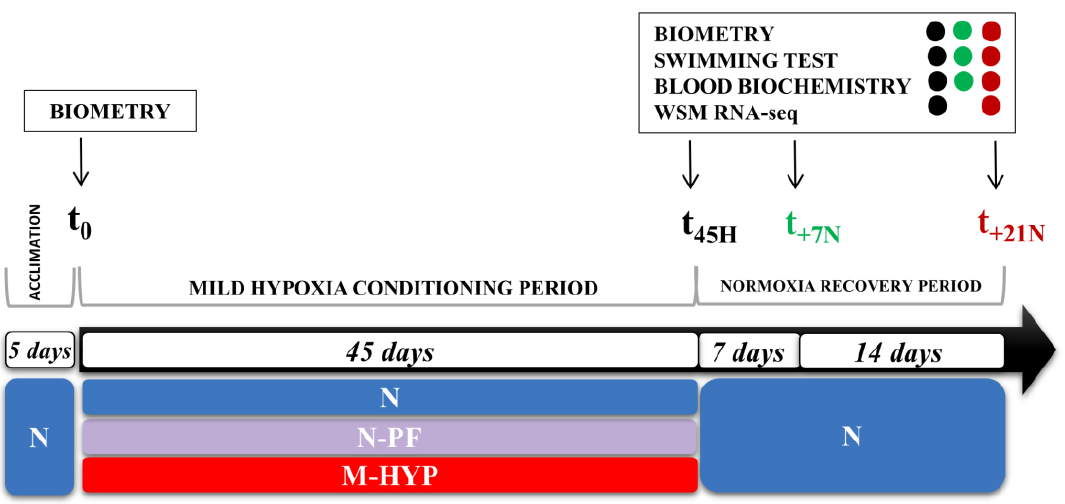
Figure 1. Experimental setup showing the timing and type of data recorded at each sampling point. After 45 days of mild-hypoxia conditioning (t 45H ), 12 overnight-fasted fish per experi- mental condition were randomly selected and anesthetized (between 10:00 and 12:00 a.m.) with 100 mg/L 3-aminobenzoic acid ethyl ester (MS-222, Sigma, Saint Louis, MO, USA). Blood was taken from caudal vessels with heparinized syringes in less than 3 min for all the fish from the same tank. The haematocrit (Ht) and haemoglobin concentration (Hb) were determined in fresh samples. The remaining blood was centrifuged at 3000 × g for 20 min at 4 ◦ C, and plasma samples were frozen and stored at − 20 ◦ C until biochemical and hormonal analyses were performed. Prior to skeletal muscle collection, fish were killed by cervical section and representative portions of the dorsal tissue were excised and immediately snap-frozen in liquid nitrogen and stored at − 80 ◦ C until extraction of total RNA and tissue lactate quantification. At this stage, 6–7 additional fish per experimental condition were used for swim tests (see Section 2.3), and blood and skeletal muscle were rapidly taken from exhausted fish for biochemical and transcriptomic analyses. The re- maining fish were kept under normoxia and continued to be fed until visual satiation for three additional weeks, which constituted the normoxia restoration period with additional sampling points at Week 1 (t +7N ; 6 fish) and Week 3 (t +21N ; 7 fish) for swim tests as well as biochemical and transcriptomic analyses. Data on body weight were retrieved for all fish at t 0 , t 45H , t +7N , and t +21N (see Figure